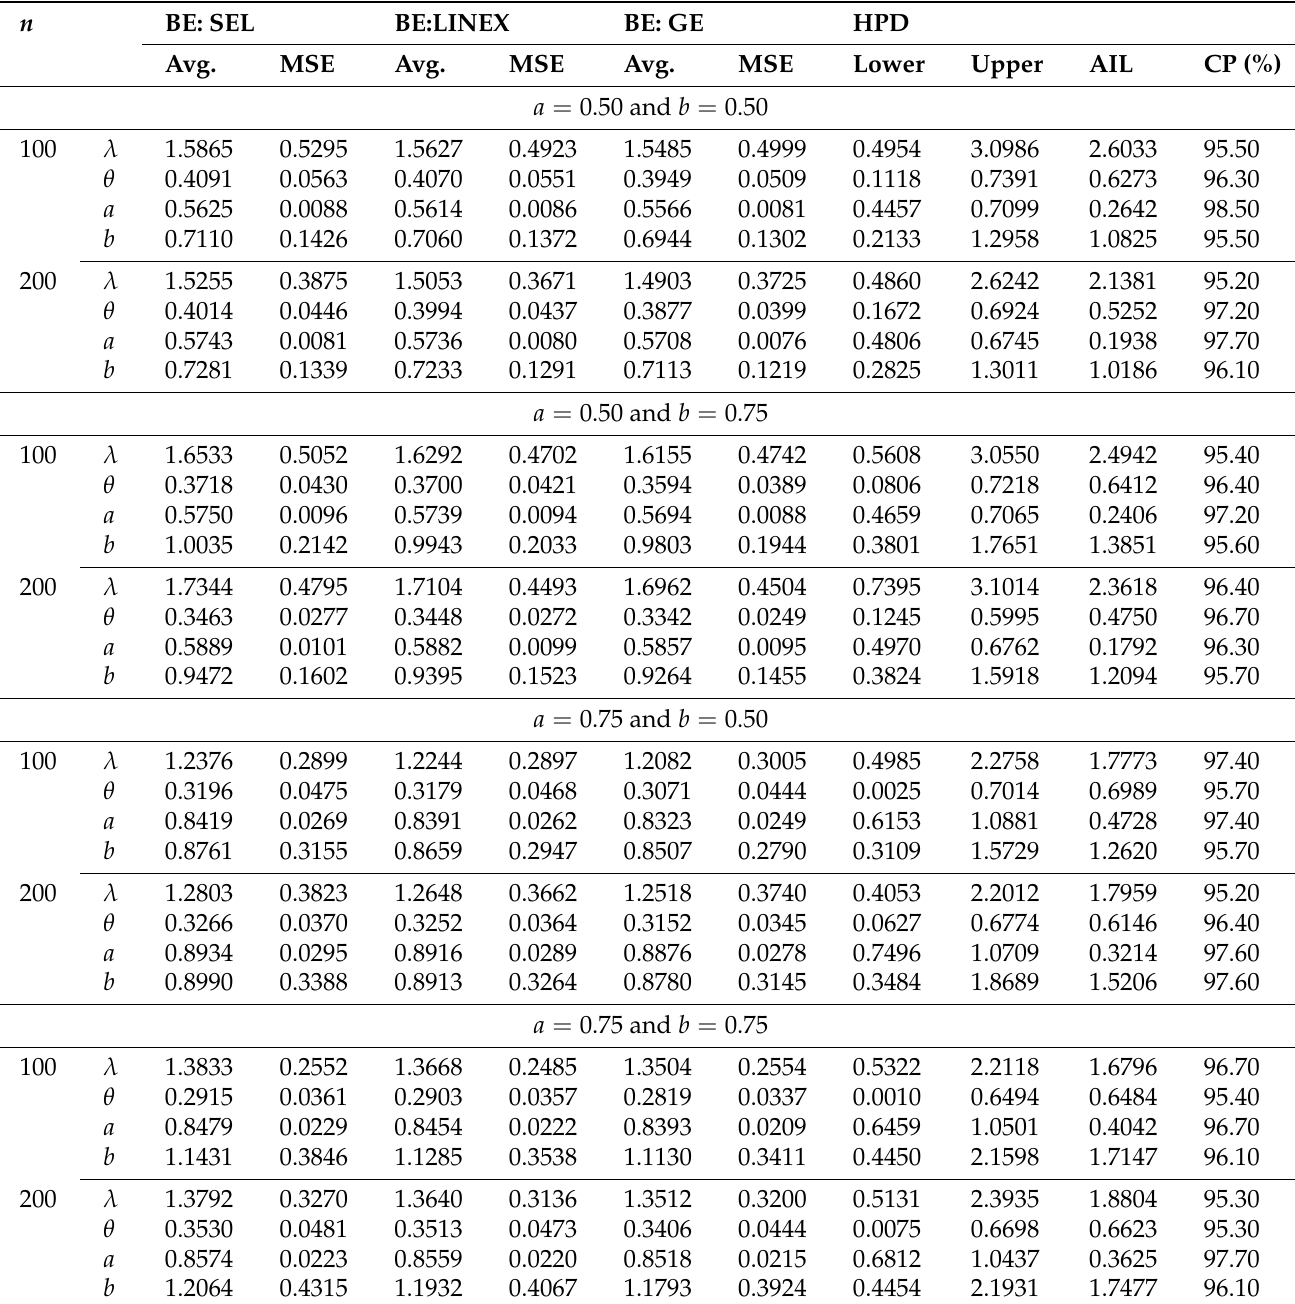
Table 11. Avg. estimated values and MSEs of the BE using MCMC for the BBE 2 distribution